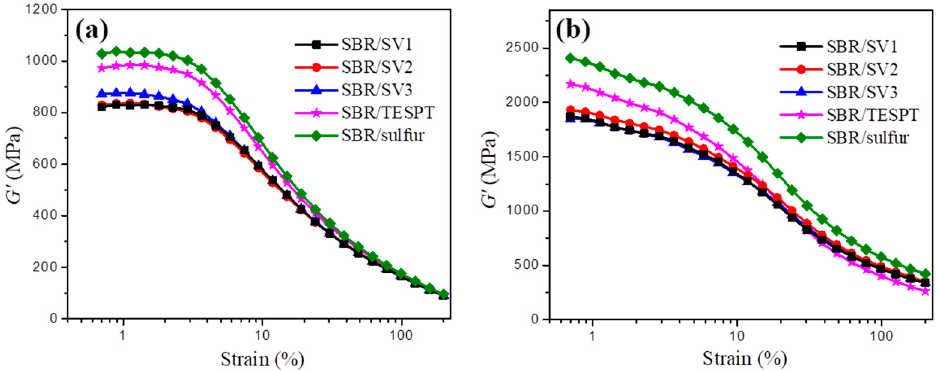
Figure 5. Dependence of G’ of ( a ) unvulcanizated ( b ) vulcanizated SBR/silica nanocomposites.